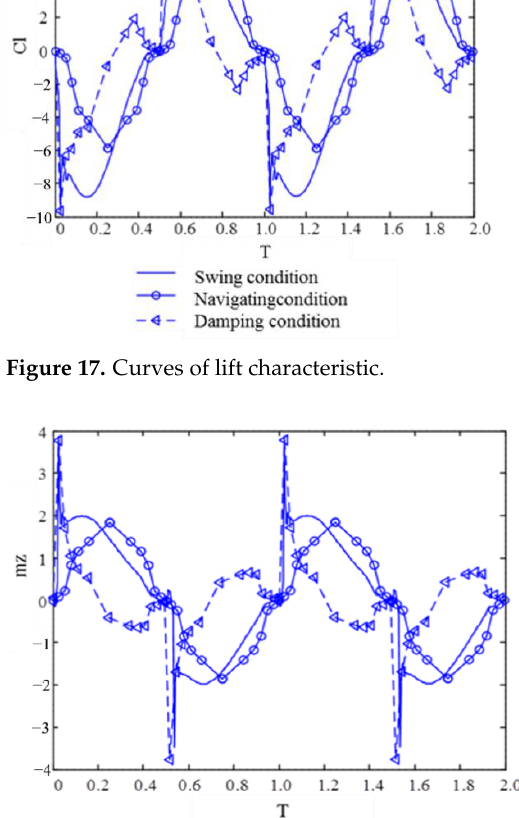
Figure 18. Curves of pitching moment characteristic.